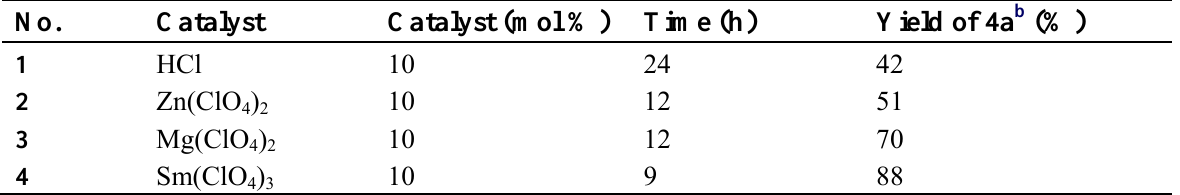
a Reaction conditions: 2-phenyl-1,2,3-triazole-4-carbaldehyde (2 mmol), ethyl acetoacetate (2